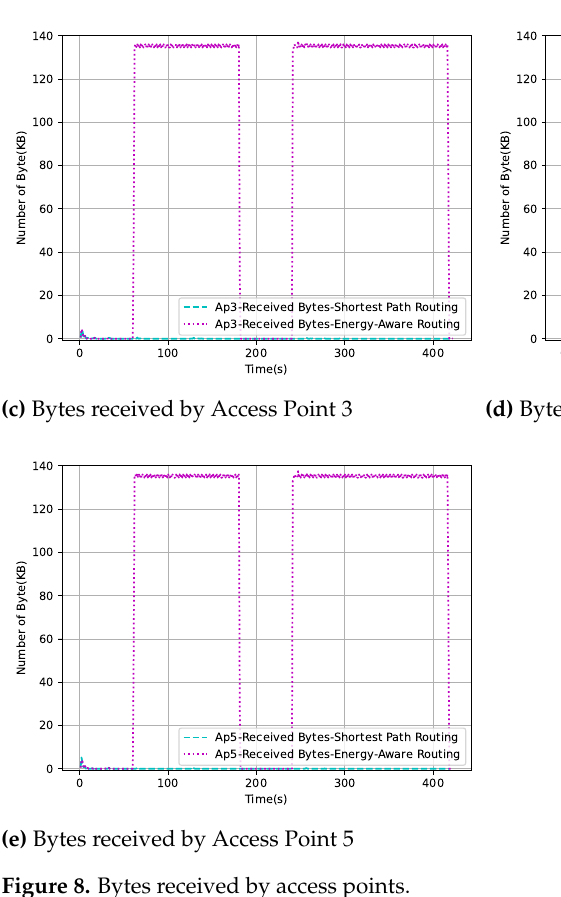
Figure 8. Bytes received by access